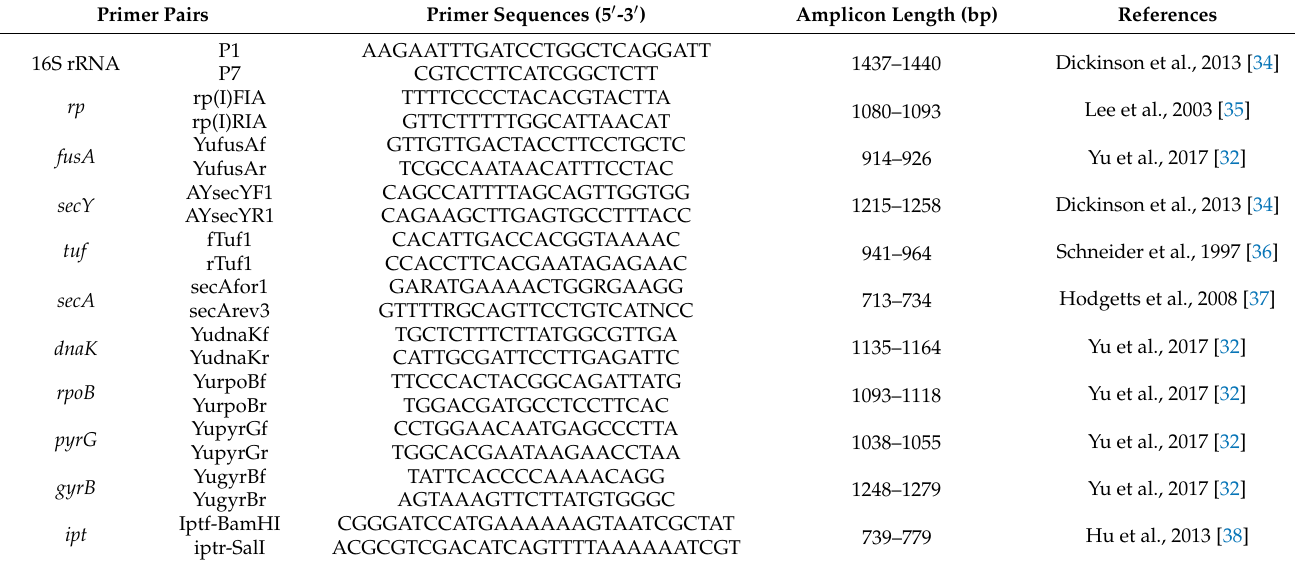
Table 1. Universal and specific primers used to amplify each PaWB phytoplasma MLST locus. Primer Pairs Primer Sequences (5 (cid:48) -3 (cid:48) ) Amplicon Length